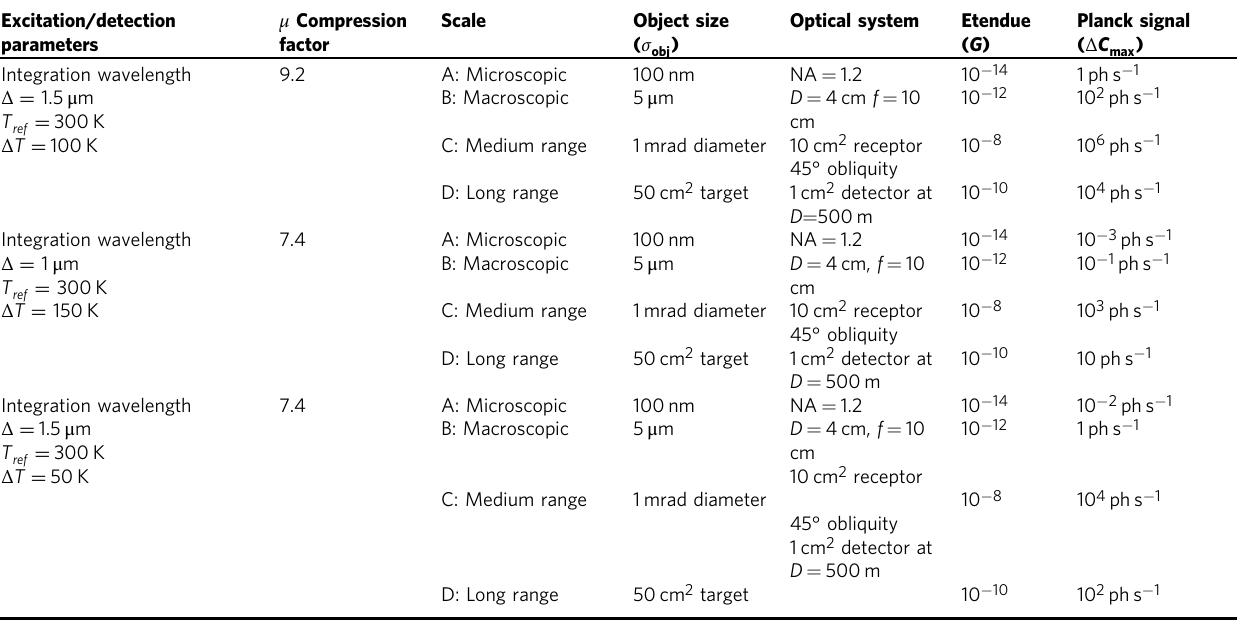
Table 1 Photon budget and psf thermal compression